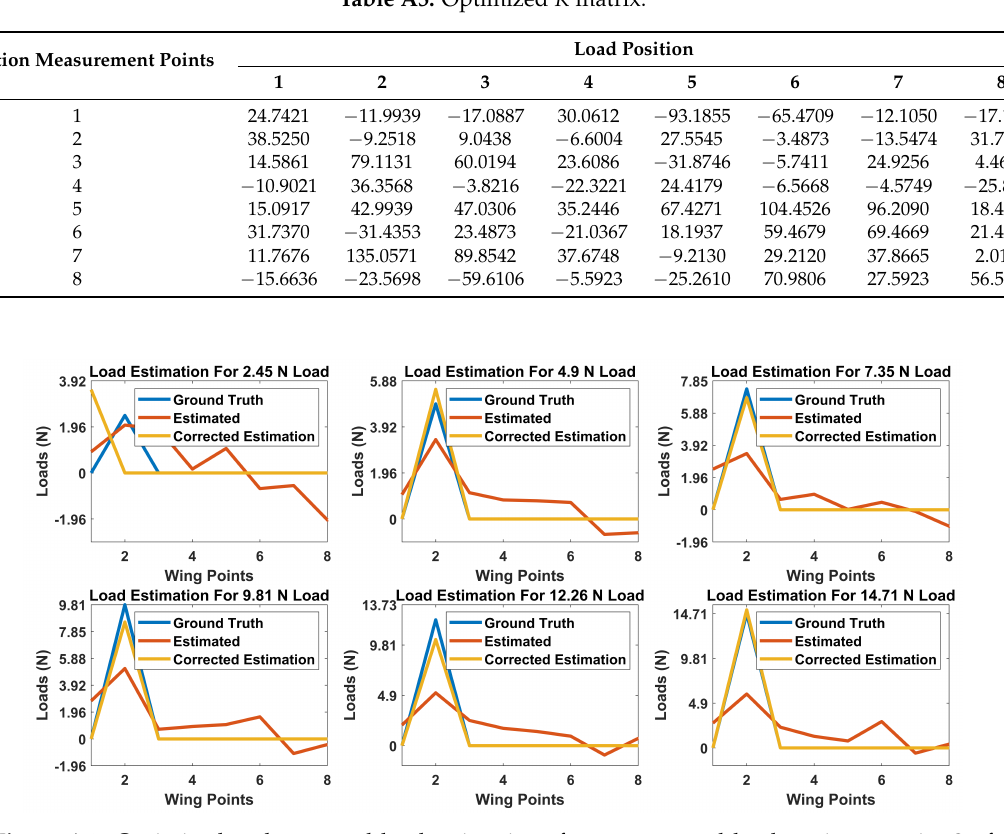
Table A5. Optimized ˆ K matrix.